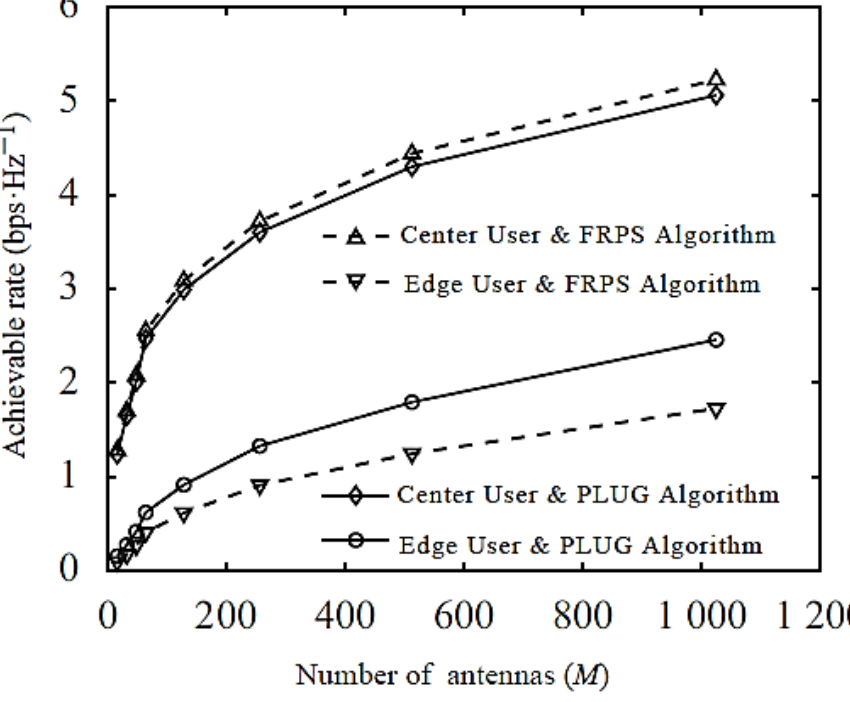
Figure 10. Comparison achievable rate of target cell of FRPS and PLUG algorithms.